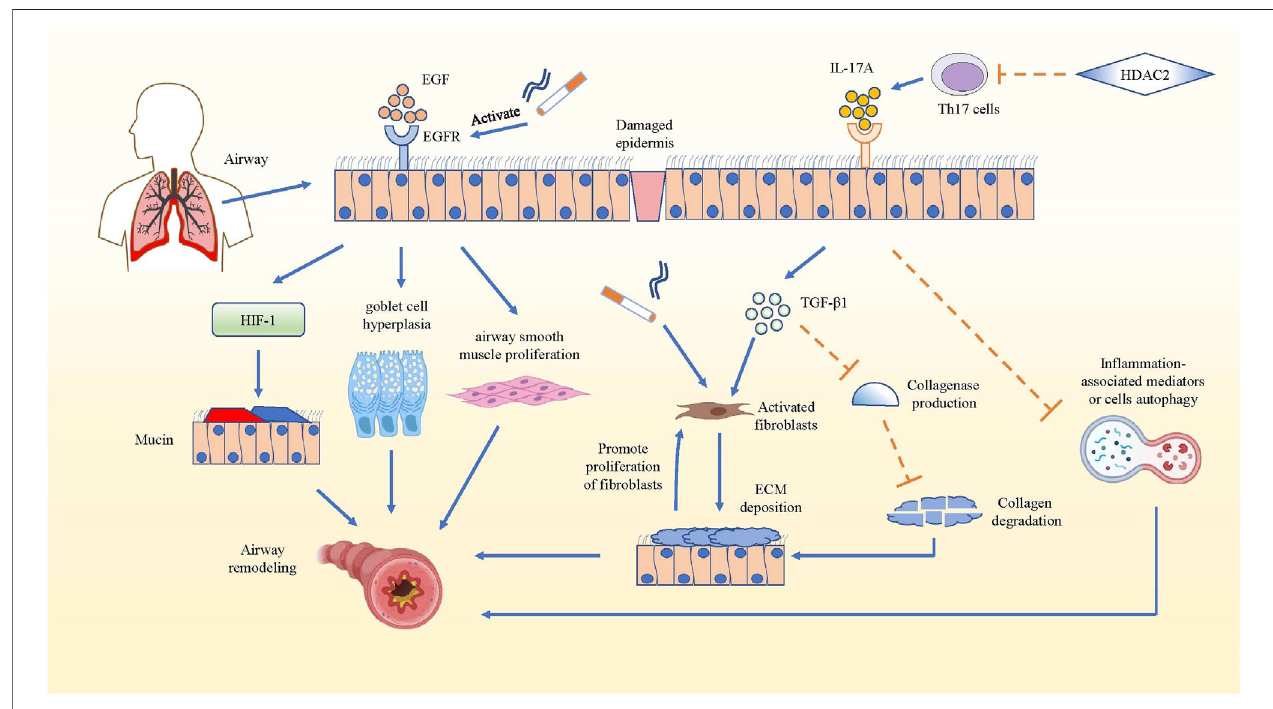
FIGURE 2 | IL-17A promotes airway remodeling in COPD. The mechanism that IL-17A promotes airway remodeling by increasing collagen deposition and inhibiting in fl ammation-associated mediators or cells autophagy are summarized. In COPD airway remodeling, the activated EGFR facilitates the production of mucin5AC via hypoxiainduciblefactor-1(HIF-1)pathway,promotesgobletcellhyperplasiaandairwaysmoothmuscleproliferation.WhileIL-17AproducedbyTh17cells activates fi broblasts to secrete ECM and inhibit the collagen degradation in TGF- β 1-dependent manner, and IL-17A also could hampers the autophagy of in fl ammation-associatedmediators, whichpromotesdevelopmentand progressionofpulmonary fi brosis. Actually,thedepositionofECMalsohaspositiveeffect onthe proliferation of fi broblasts, which strengthens ECM deposition. However, HDAC2 reverses the above result by inhibiting the differentiation of Th17 cells.